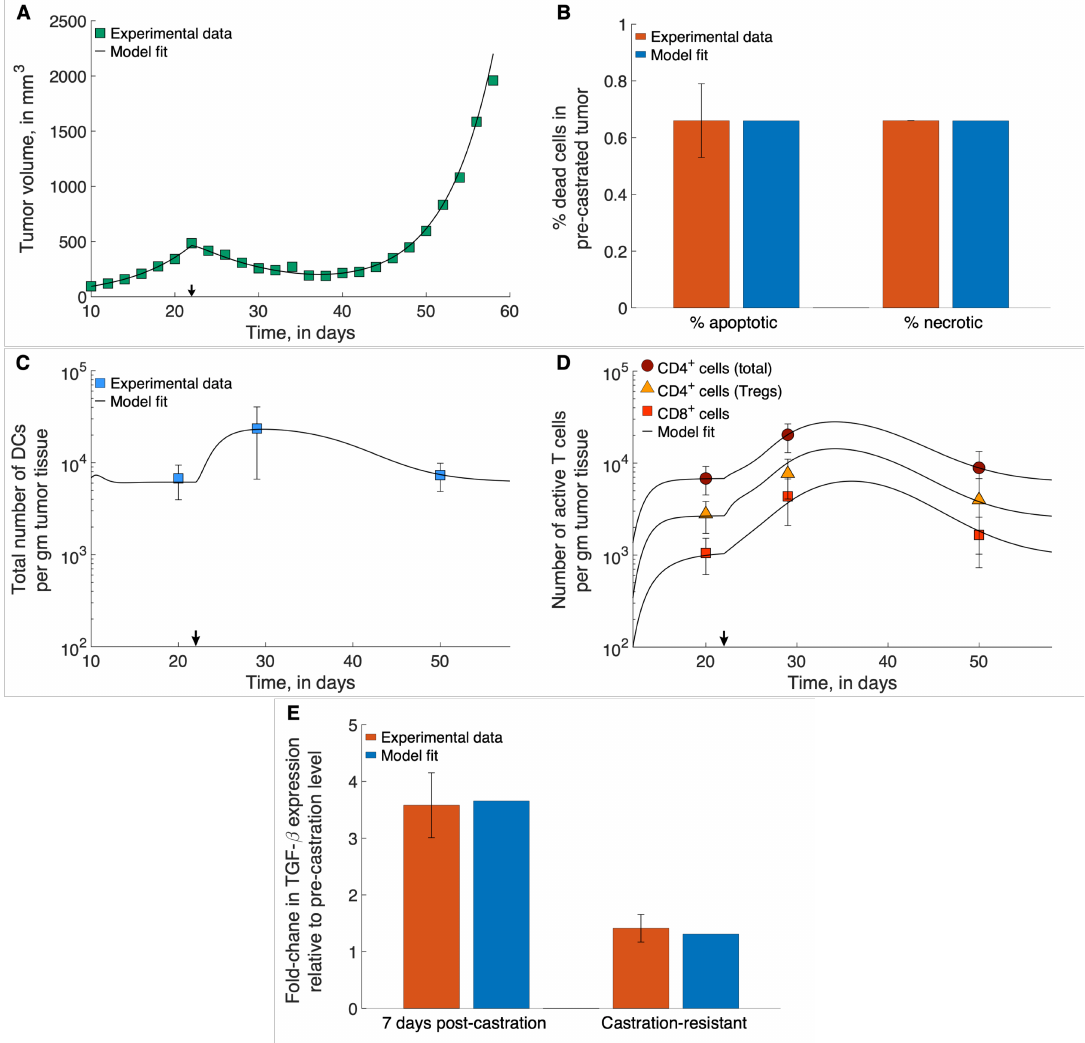
Figure 2. Model fits to data. ( A ) Model fitted to time-course treatment data on PCa xenograft volume, showing spontaneous emergence of castration resistance (black arrow indicates onset of ADT). ( B ) Model fitted to data on degree of apoptosis and necro- sis in PCa xenografts, in the absence of treatment. ( C , D ) Model fitted to time-course treatment data on PCa xenograft immune cell infiltration (black arrow indicates onset of ADT). ( E ) Model fitted to fold-changes in TGF- β expression within the xenografts 7-days post-ADT administration, and after the emergence of castration-resistance. Data were taken from